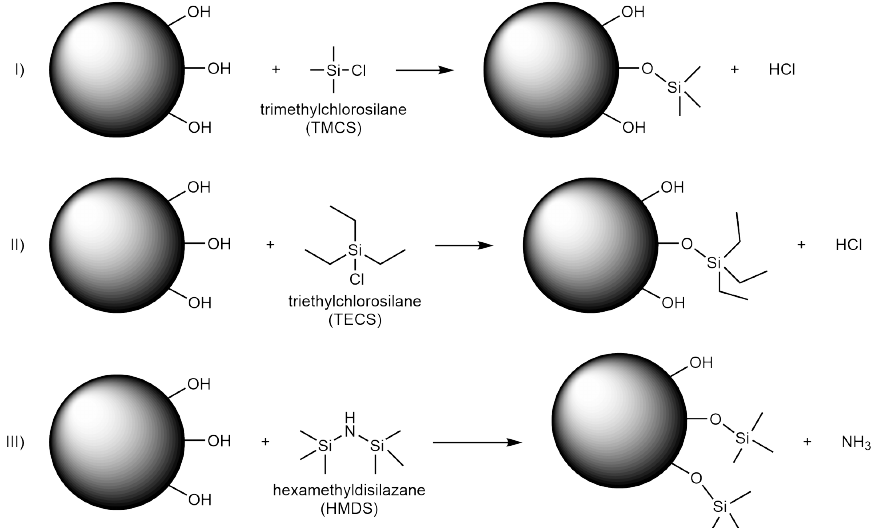
Figure 1. Proposed mechanisms of the silica gel network for ( I ) hydrophobization by trimethylchlorosilane, ( II ) triethylchlorosilane, and ( III ) hexamethyldisilazane. The silanol end groups react with the respective silylation agents, while splitting off either hydrochloric acid or ammonia.